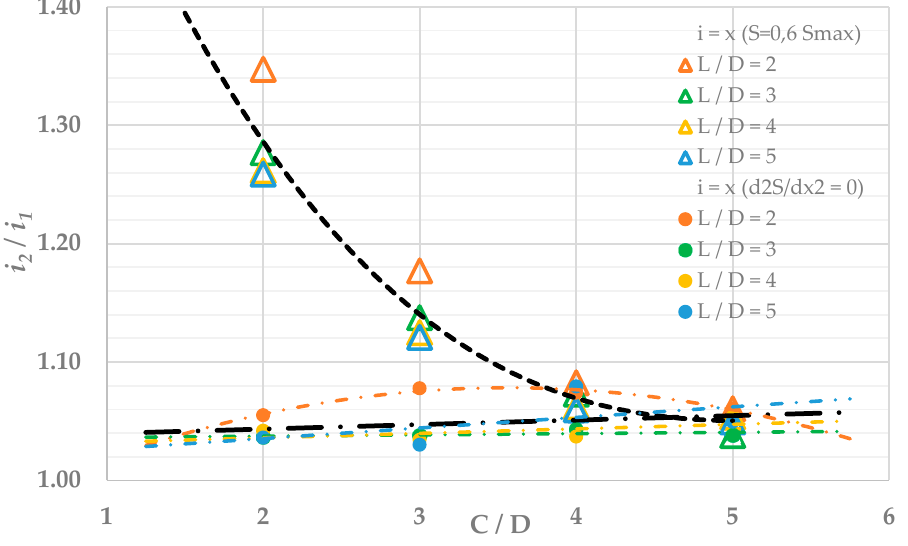
Figure 7. Geometry influence on the settlement trough the width.